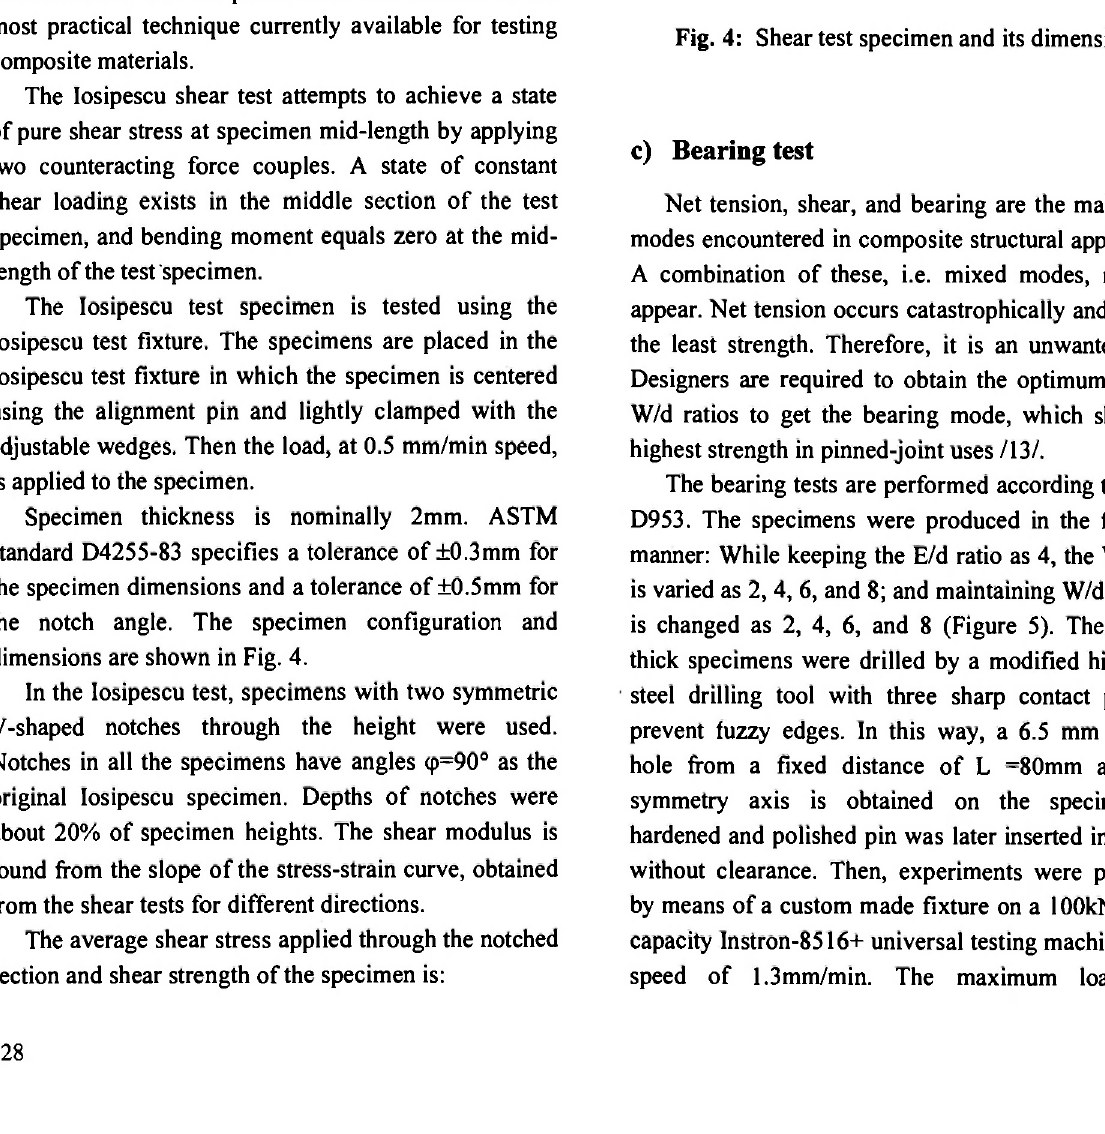
Fig. 4: Shear test specimen and its